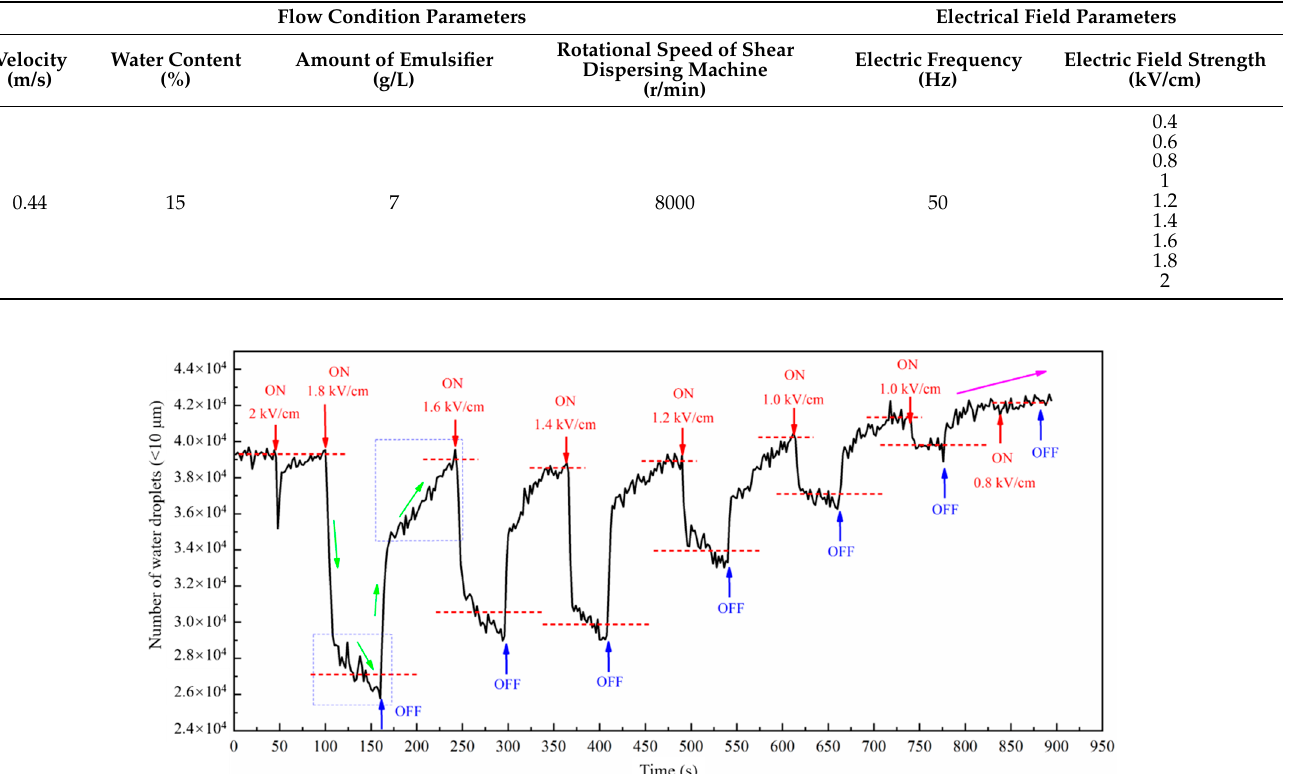
Table 2. Parameters to study the influence of electric field strength on demulsification.